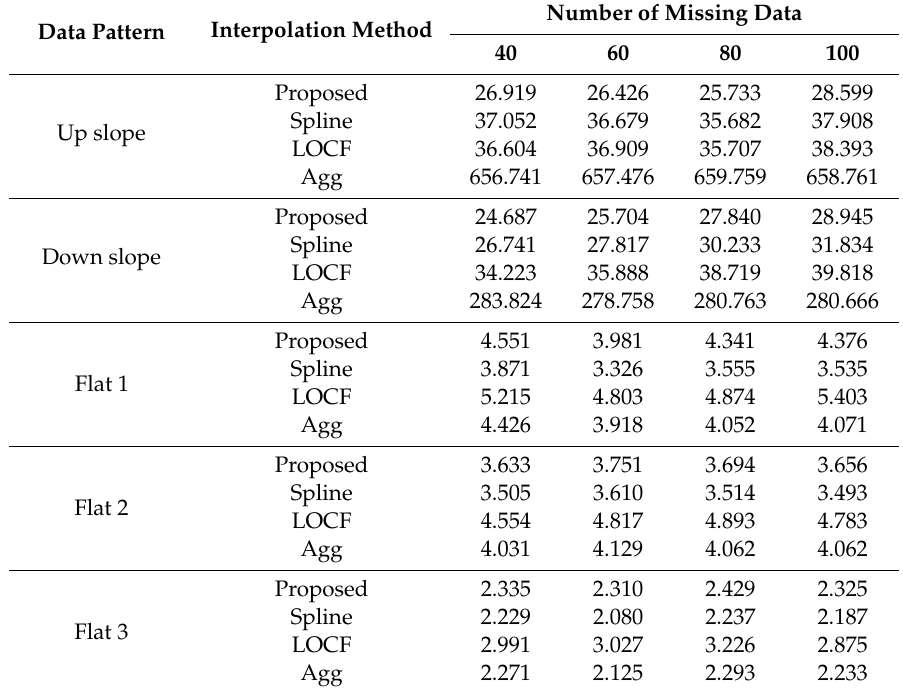
Table 1. Root mean squared errors (RMSEs) of the four interpolation methods applied to our real-time personal monitoring data. LOCF: last observation carried